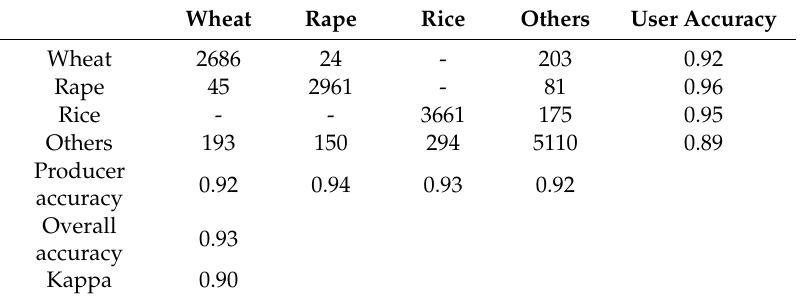
Table 5. Accuracy assessment using the interpreted images from Google Maps for the